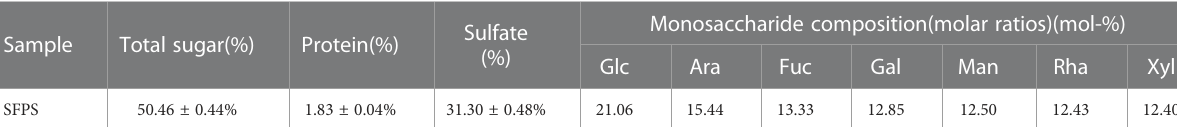
Table 1. The prepared SFPS contained 50.46 ± 0.44% total sugar, 31.30 ± 0.48% sulfate and 1.83 ± 0.04% protein. Further analysis of monosaccharide composition of the SFPS was